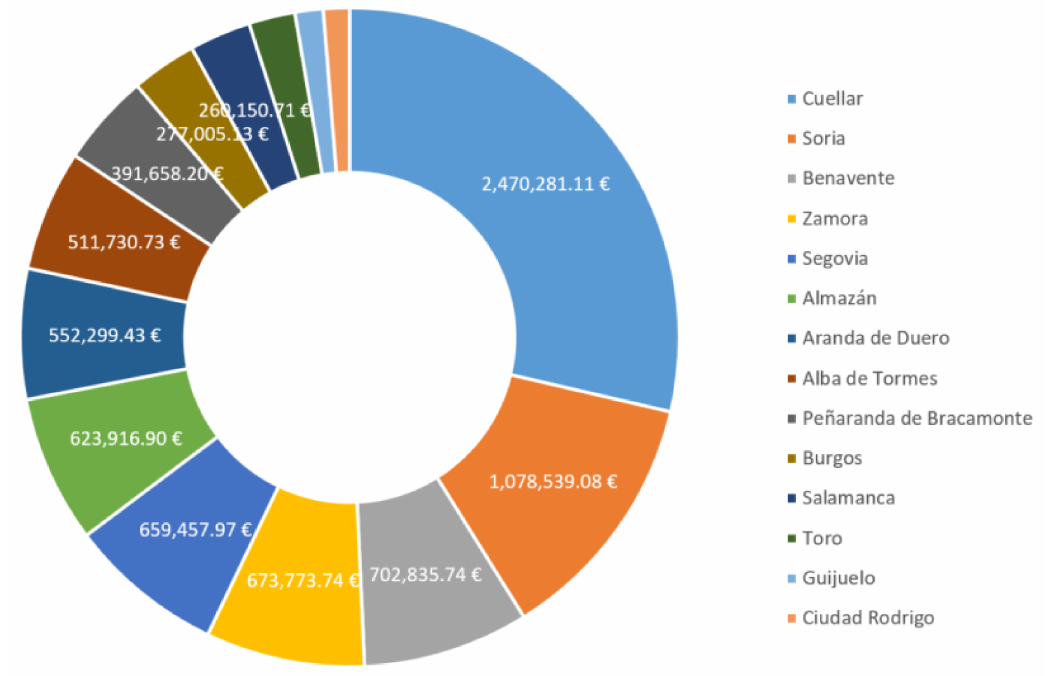
Figure 4. Expected incomes from the production of energy from the proposed generation